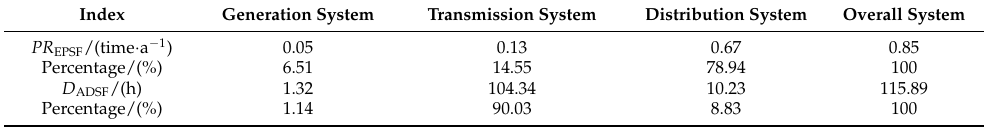
Table 7. System failure indicators.